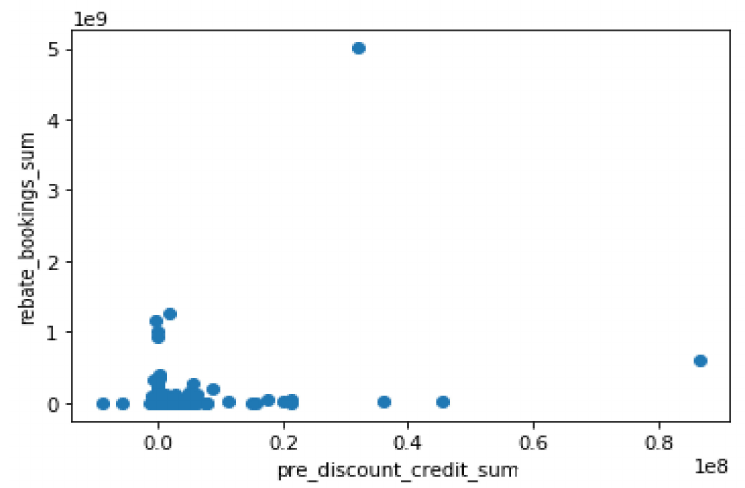
Figure 8. Whole scatter distribution of discount features (Notes: le8 means unit of measurement 10 8 , le9 means unit of measurement 10 9 ).